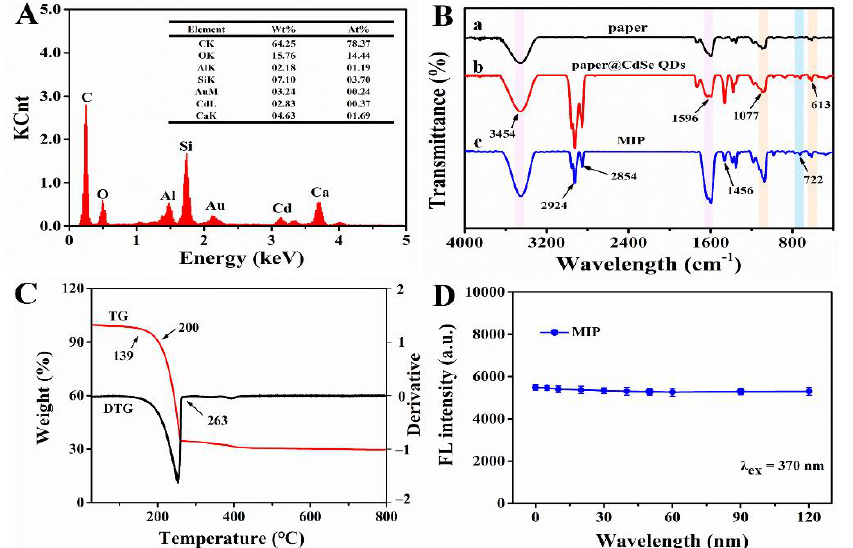
Figure 6. ( A ) EDS image of imprinted paper chip. ( B ) FT-IR spectra of (a) CB06 paper substrate, (b) substrate@ CdSe QDs, (c) imprinted paper chip. ( C ) TG and DTG curves for imprinted paper chip. ( D ) Fluorescence stability of imprinted paper chip.